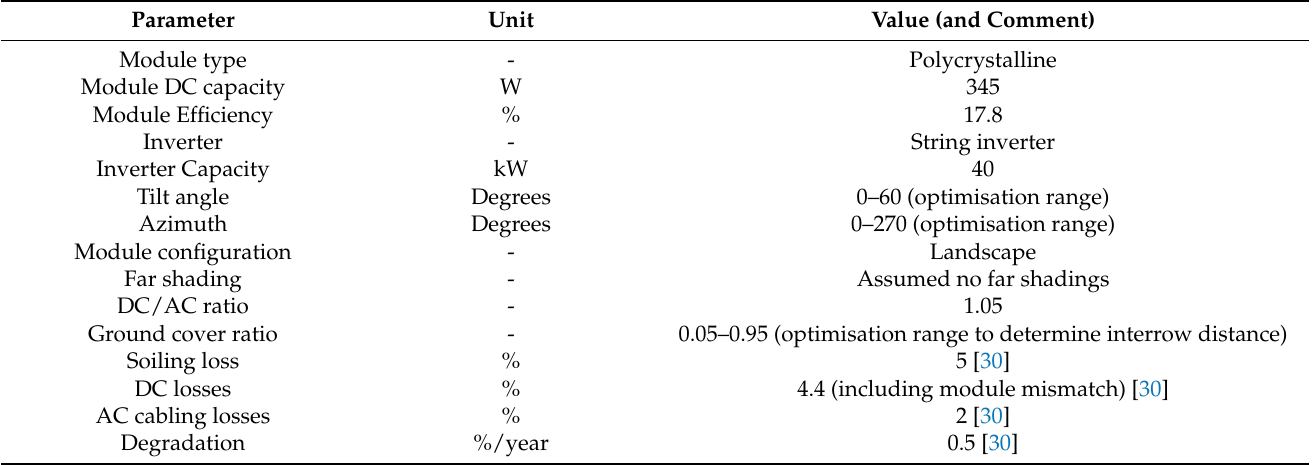
Table 6. Technical parameters for the PV plant.